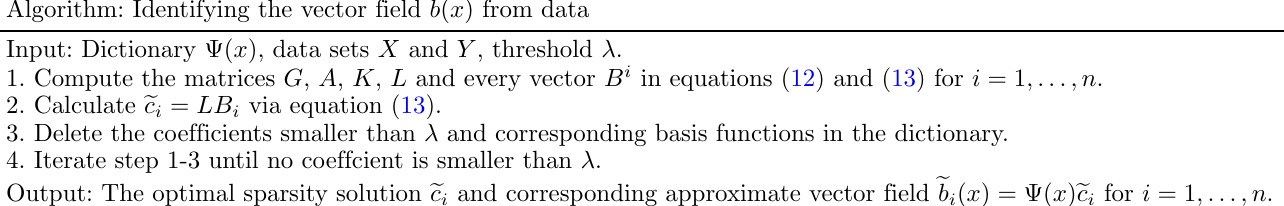
Table 3. The algorithm for identifying the vector field from data. Algorithm: Identifying the vector field b ( x ) from data